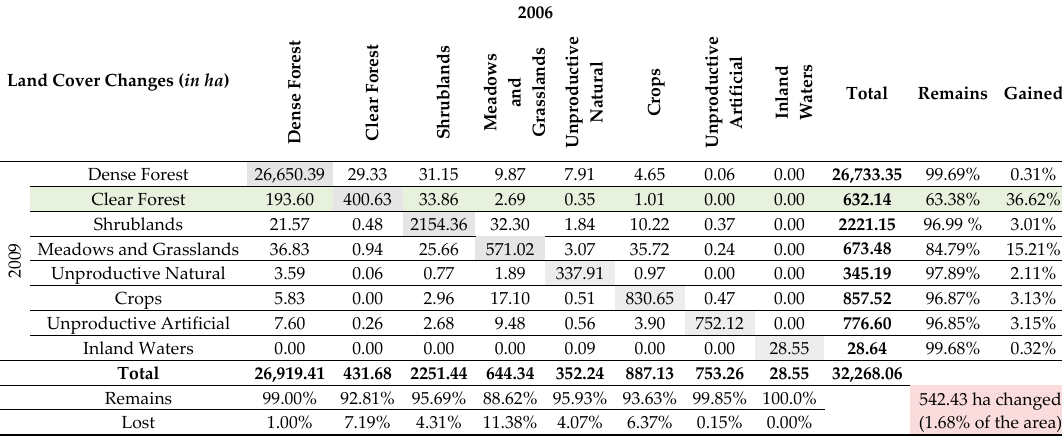
Table 5. Land cover changes (in ha) in the Mass í s del Montseny protected area between 2006 and 2009. The total changed area is shown in the red shadowed cell in the bottom right area of the table (summing up the change value, i.e., all except for the grey shaded cells). Green shaded row highlights which category was in 2006 the area classified in 2009 as Clear Forests